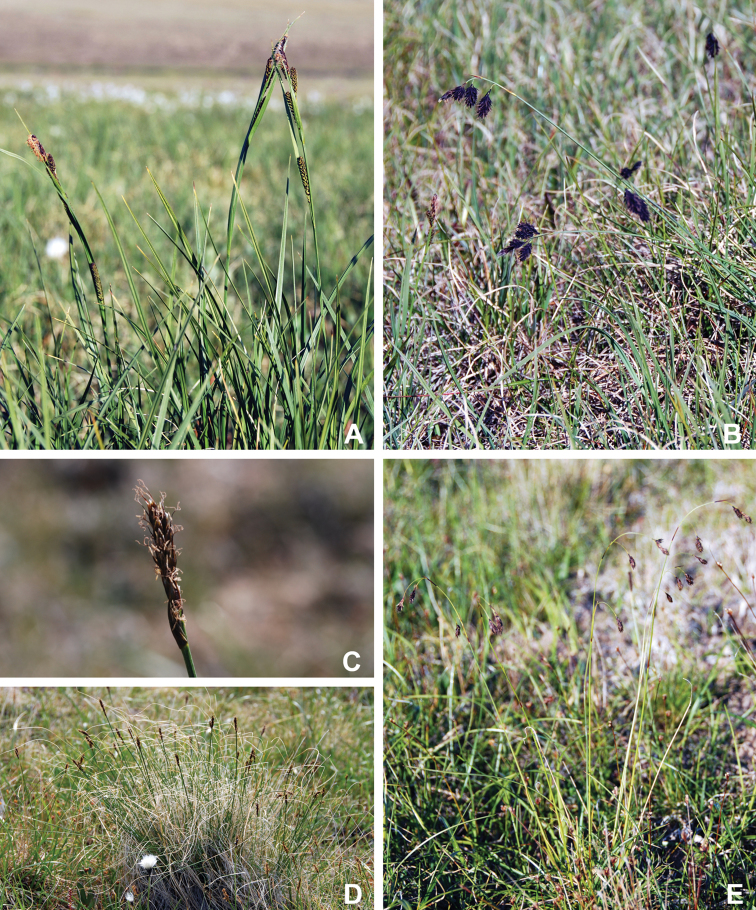
ACarex
aquatilis
subsp.
stans habit, 18 July 2010 BCarex
atrofusca habit, head of Minto Inlet, 25 July 2010 CCarex
borealipolaris inflorescence, Gillespie et al. 9900DCarex
borealipolaris habit, Gillespie et al. 9900ECarex
fuliginosa
subsp.
misandra habit, Kuujjua River, NT, 18 July 2010. Photos by J.M. Saarela.